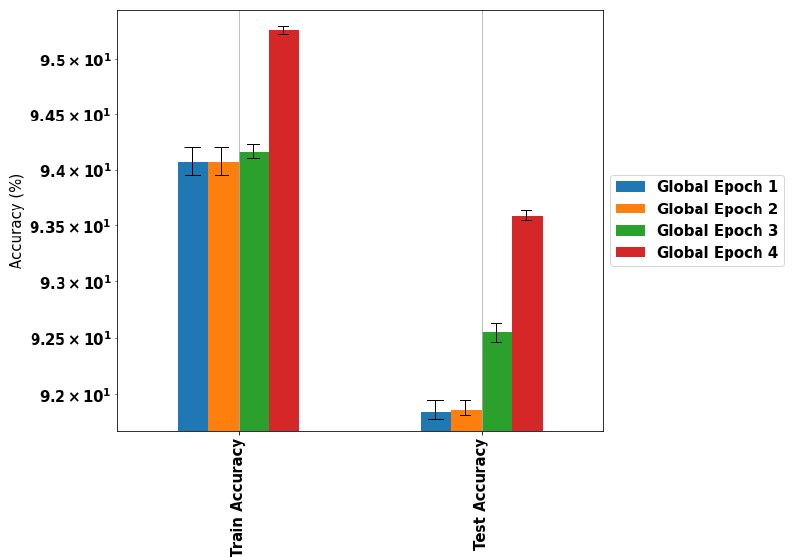
Figure 10. Experiment 3.2: Local learning effect with three agents, two local epochs, and four global epochs.